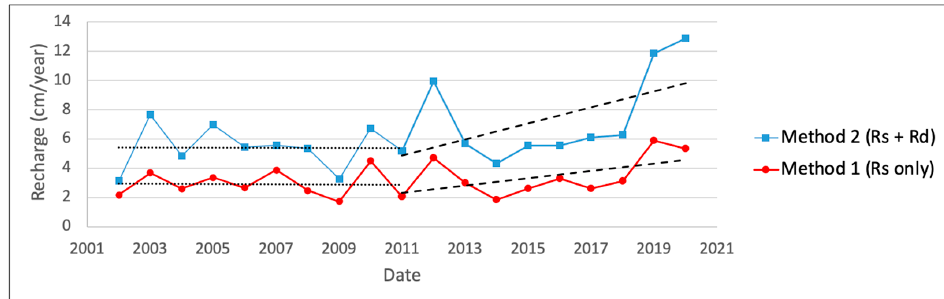
Figure 18. Estimated recharge values in the Chad basins.